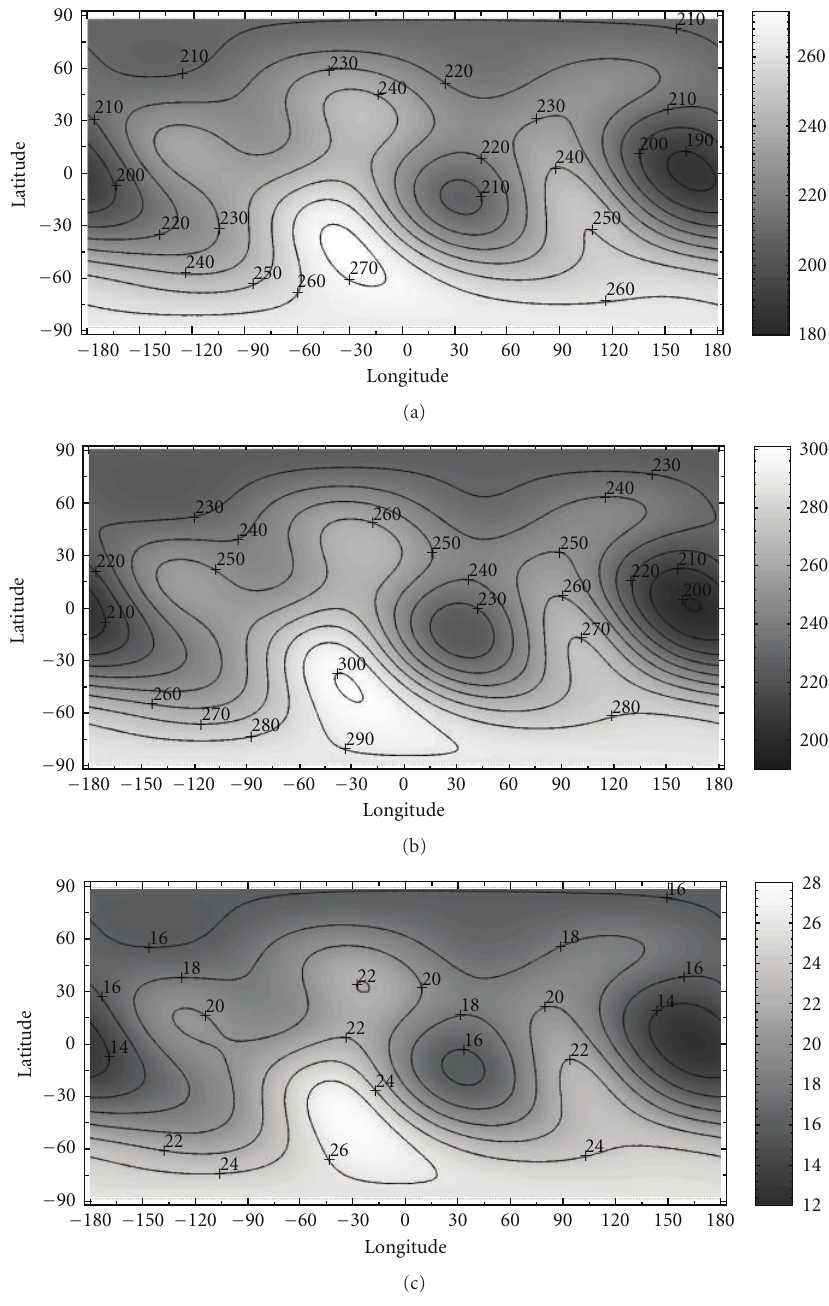
Figure 2: The global distributions of the atmospheric temperature (K) at 110km altitude, obtained from the NRLMSISE-00 empirical model for 16 January, UT = 10 . 30 and calculated for two distinct values of solar activity: F 10 . 7 = 101 (a) and F 10 . 7 = 230 (b). Also the di ff erence between the latter and the former distributions